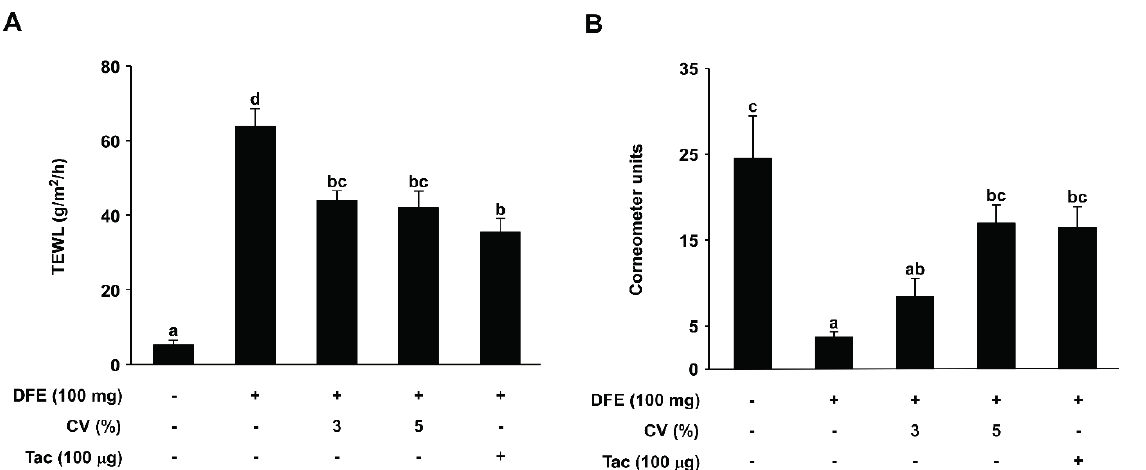
Figure 2. Effect of CV on DFE-induced downregulation of skin